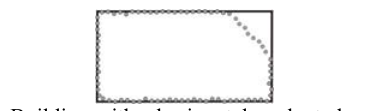
Figure 3. Building with a horizontal or slanted roof plane.